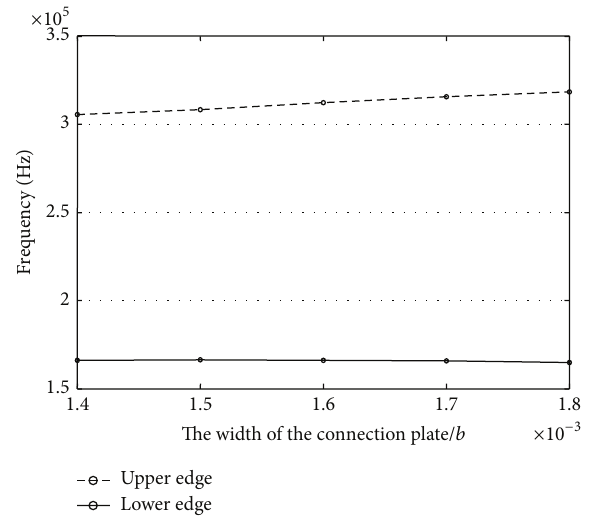
Figure 7: The evolution of the band gap as a function of the width of the connection plate 𝑏 .